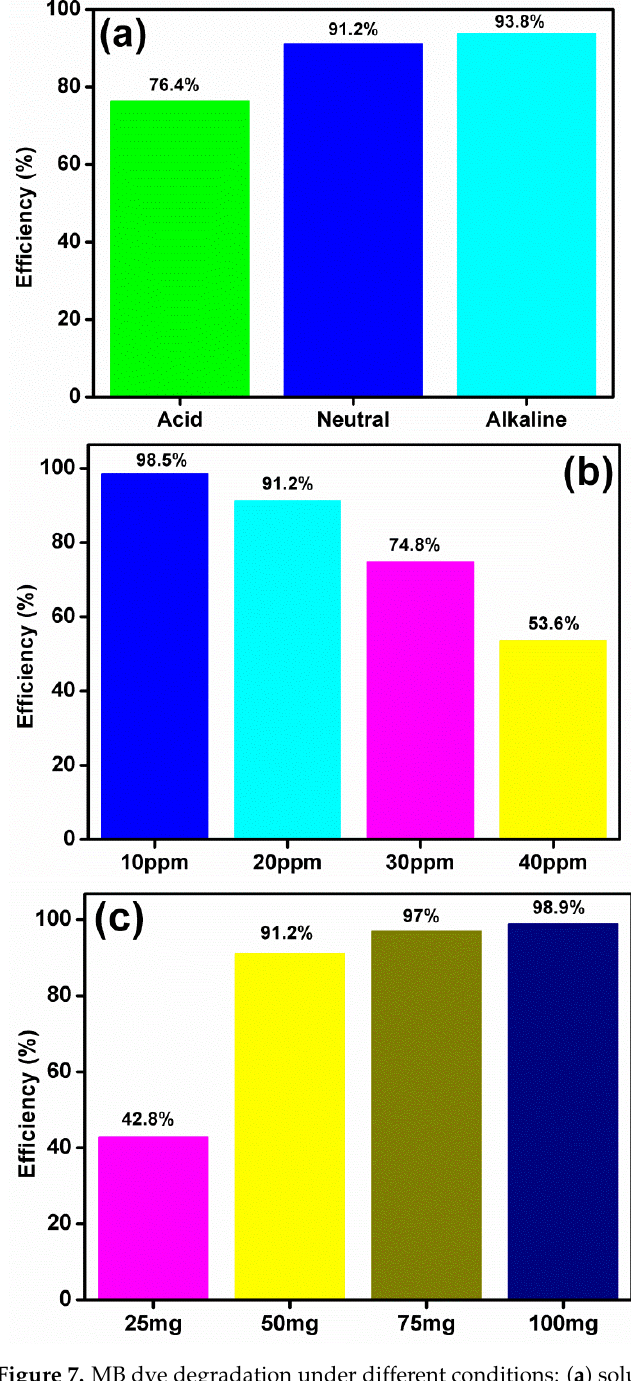
Figure 7. MB dye degradation under different conditions: ( a ) solution pH, ( b ) dye concentration and ( c ) catalyst dosage.